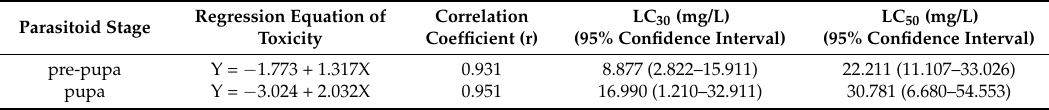
Table 7. Toxicity of imidacloprid to the pre-pupa and pupa of Encarsia formosa